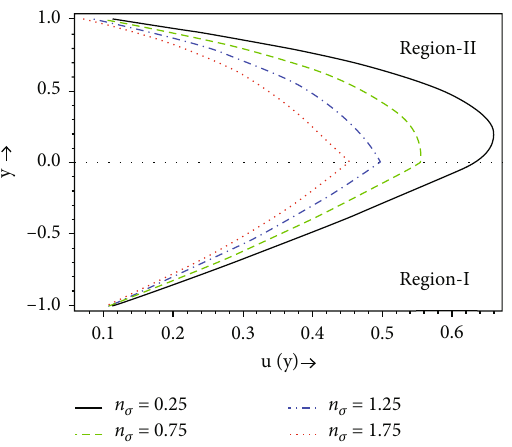
Figure 12: Velocity variation of two immiscible Newtonian fl uids with Hartmann number Ha